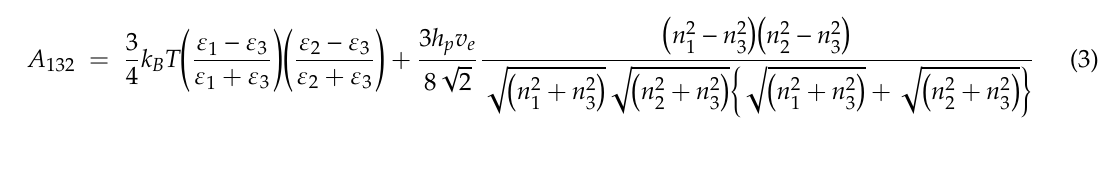
Figure 8. Zeta potential of kerosene emulsion and 0.05 wt % octyl hydroxamate-treated kerosene emulsion.